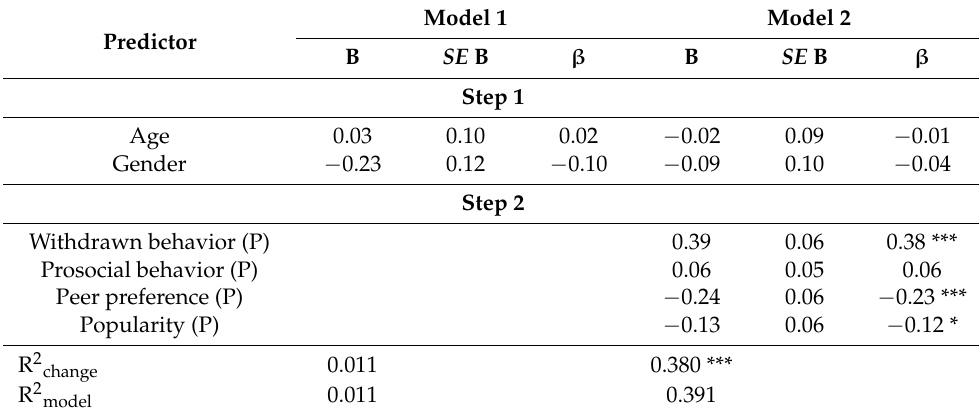
Table 6. Hierarchical Regression Model of Social Characteristics Predicting Loneliness Peer Nominations. Model Predictor